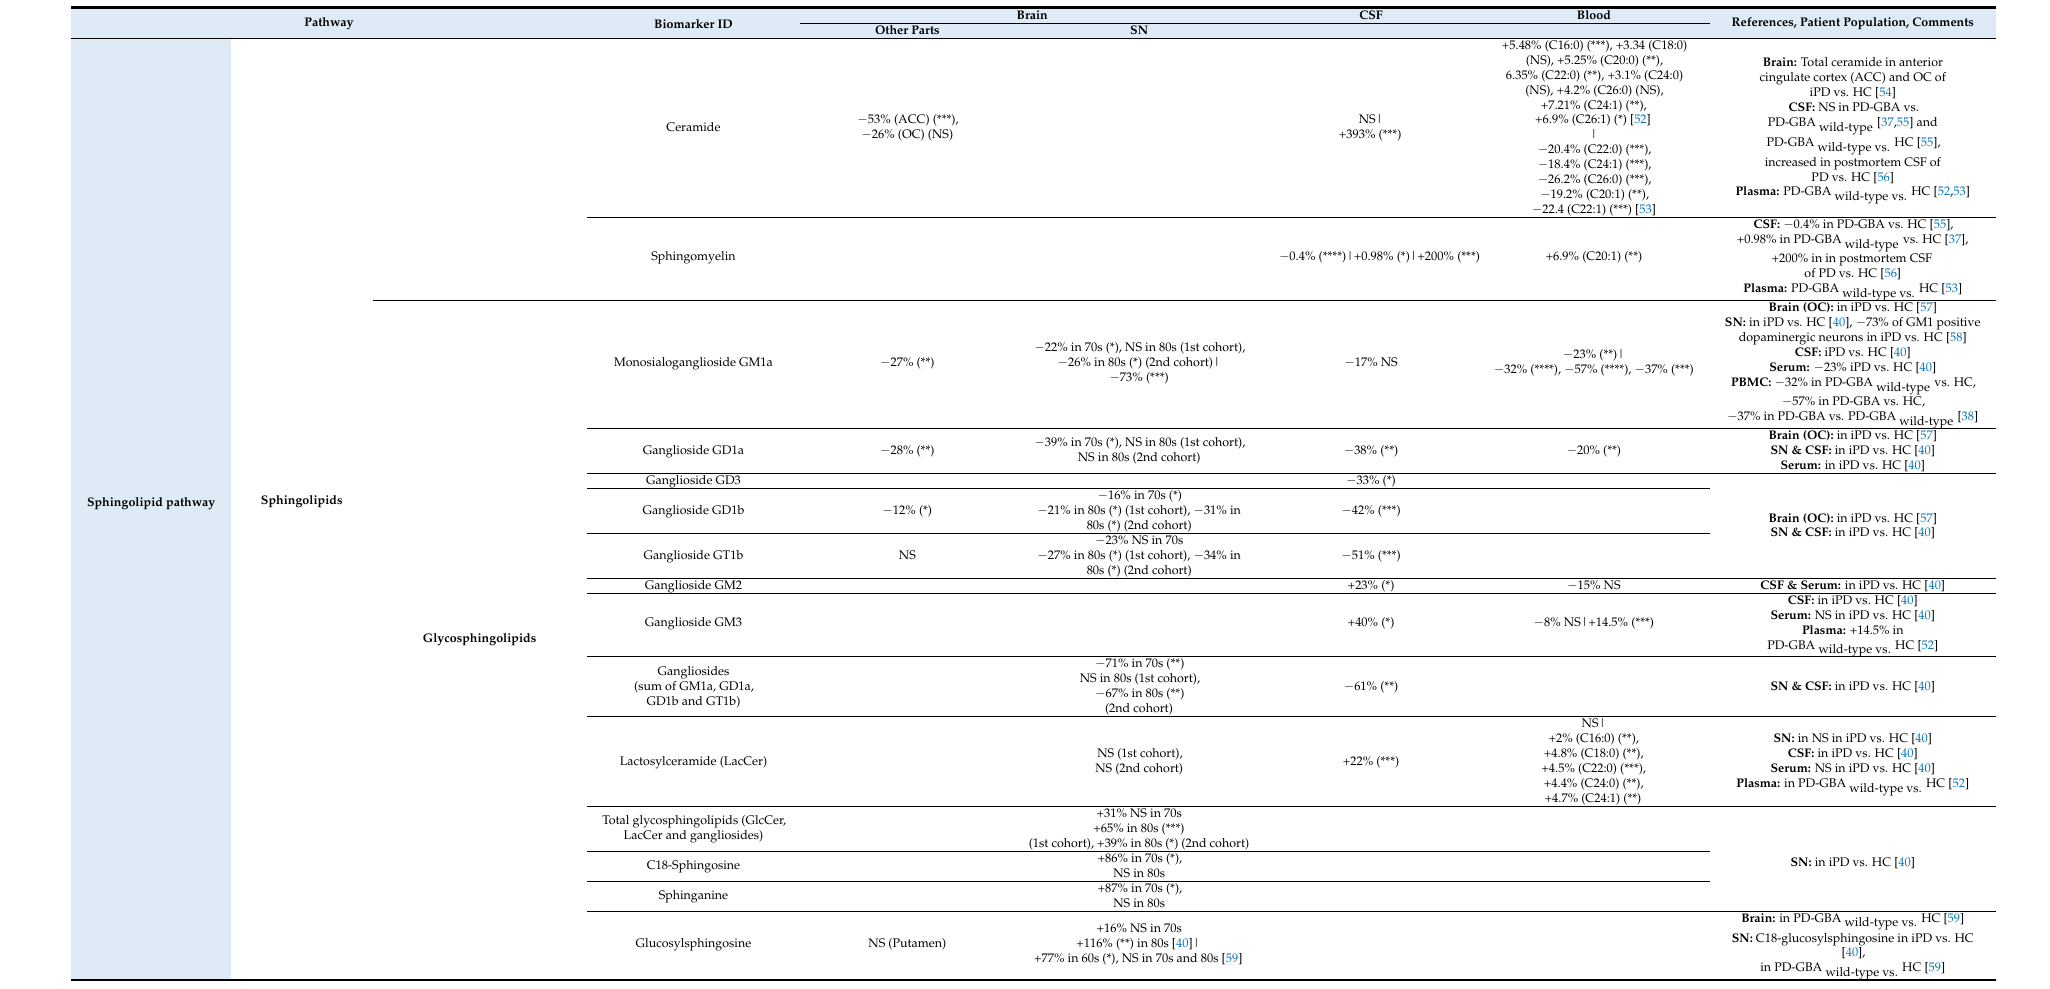
Table 1. Metabolic percentage of changes in sphingolipids pathway from postmortem PD brain are measured from CSF and/or blood compared to